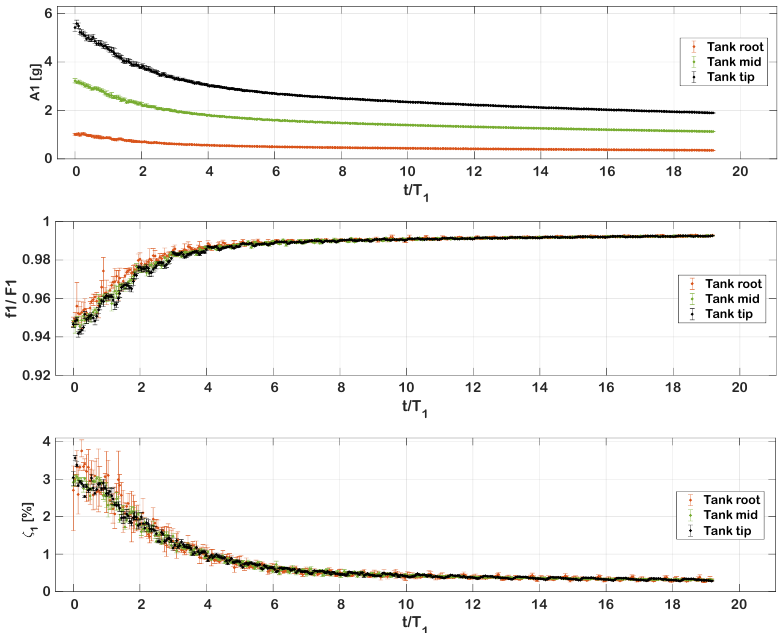
Figure 10. The amplitude, frequency and damping ratio of the first frequency component (compo- nent 1) of the acceleration time series measured throughout the fuel tank, dry